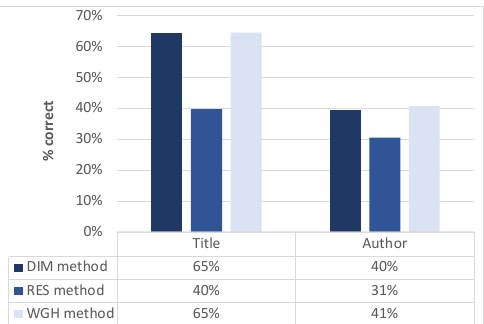
Figure 13. Title/author identification: correctness of the best guess for the different